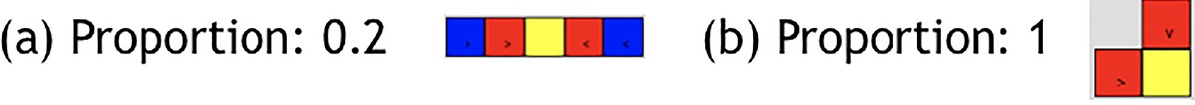
Fig 7. Morphology (a) is disproportional and (b) is